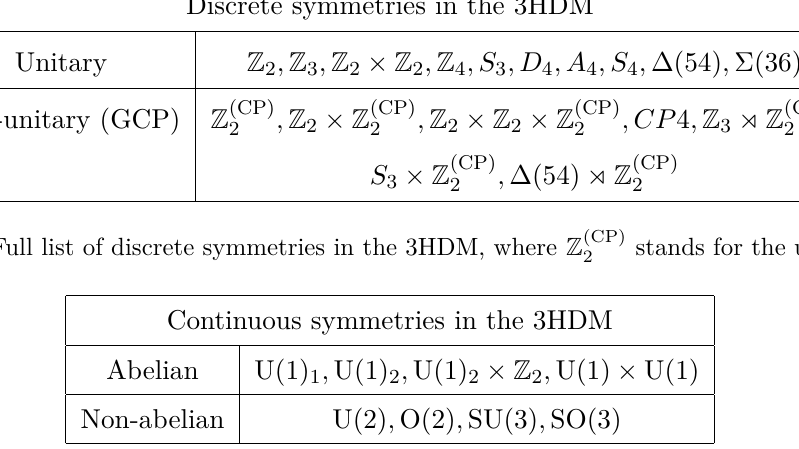
Table 2 . List of continuous symmetries in the